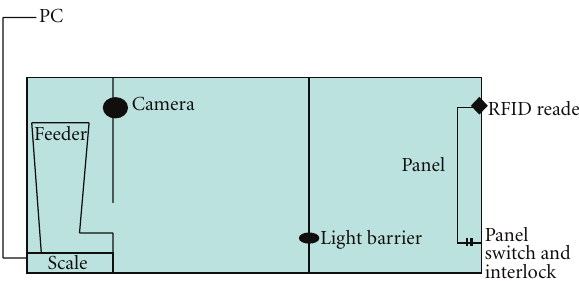
Figure 2: Design of the automatically cat food station: document- ing food intake per meal, meal frequency, visits of the station without eating, and the time of entering the station. The cats were recognized by their implanted